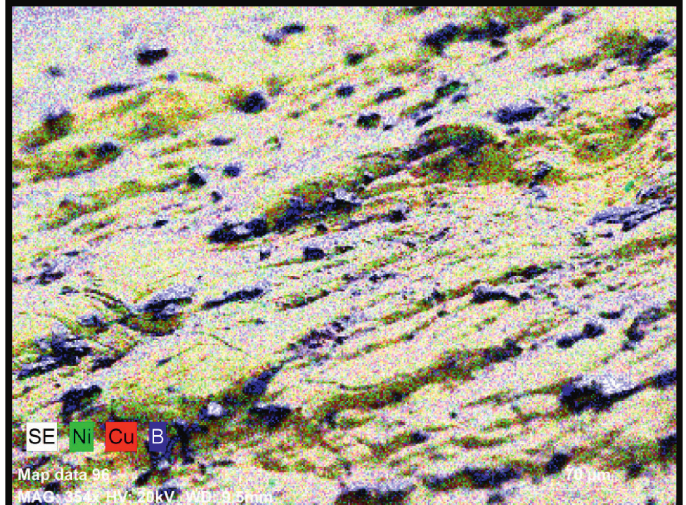
Figure 19: Spectroscopic image (mapping) showing the worn out surface of CuNi/B